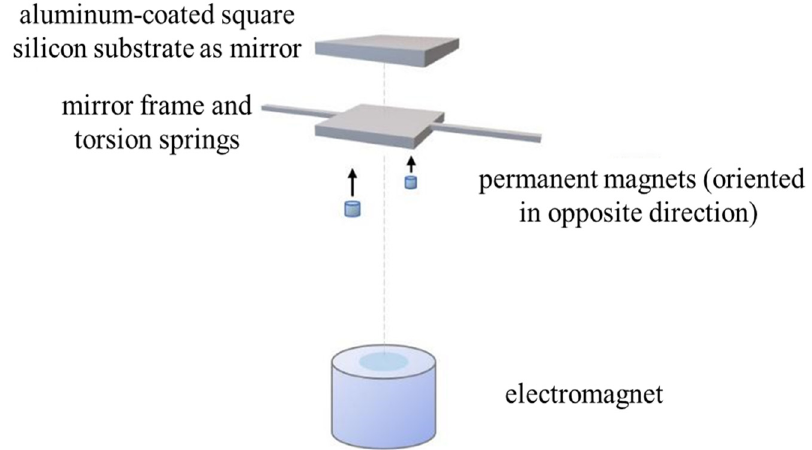
Figure 1. Exploded view drawing of the device.